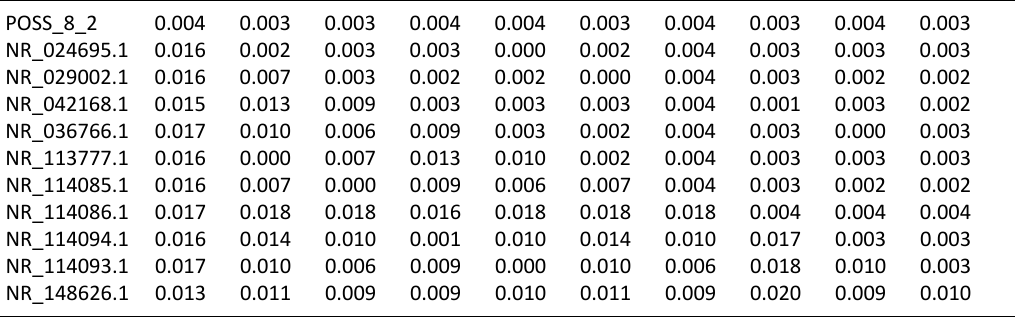
Table 3. Phylogenetic distance estimated using MEGA7 for the sample